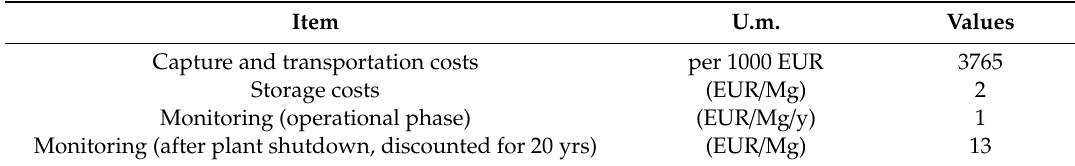
Table 5. The structure of CCS OPEX.